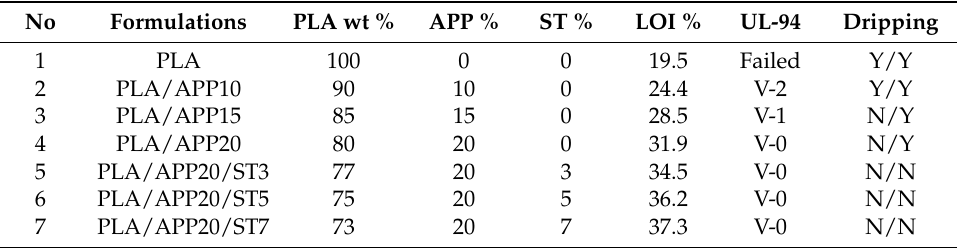
Table 1. FR properties of PLA/APP and PLA/APP/ST